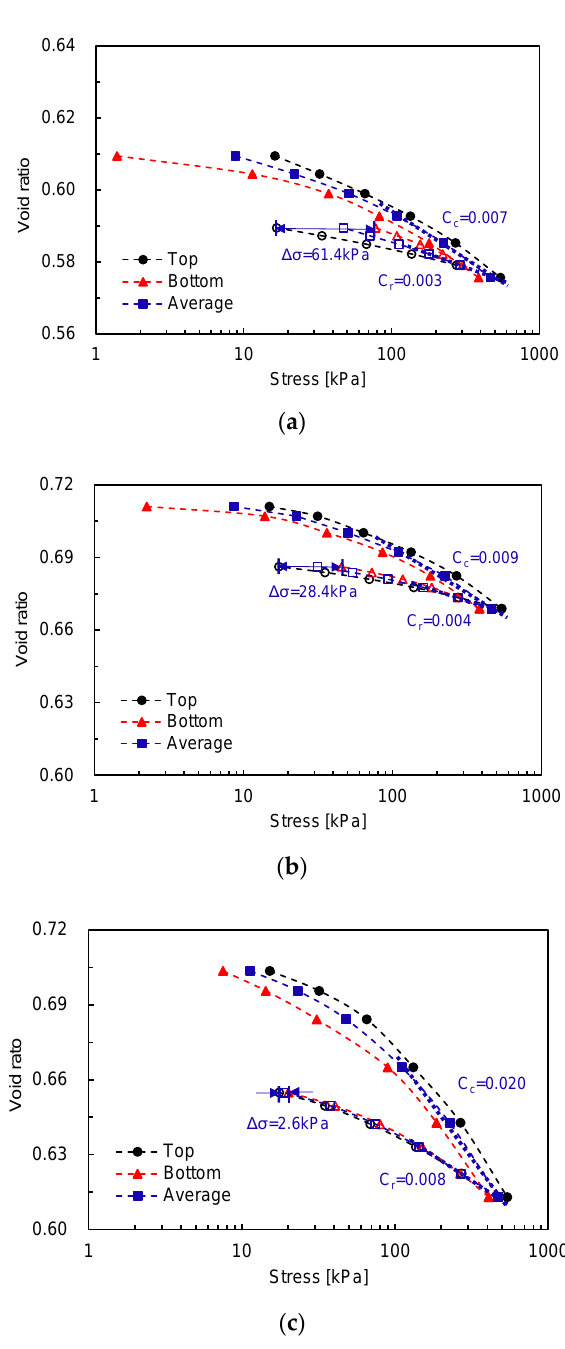
Figure 3. Variation in void ratio along the applied stress: ( a ) Dr = 80% and D/H = 1; ( b ) Dr = 40% and D/H = 1; and ( c ) Dr = 40% and D/H = 2. Note that Cc and Cr are calculated based on the average stresses. Solid and hollow markers denote the loading and unloading steps, respectively.